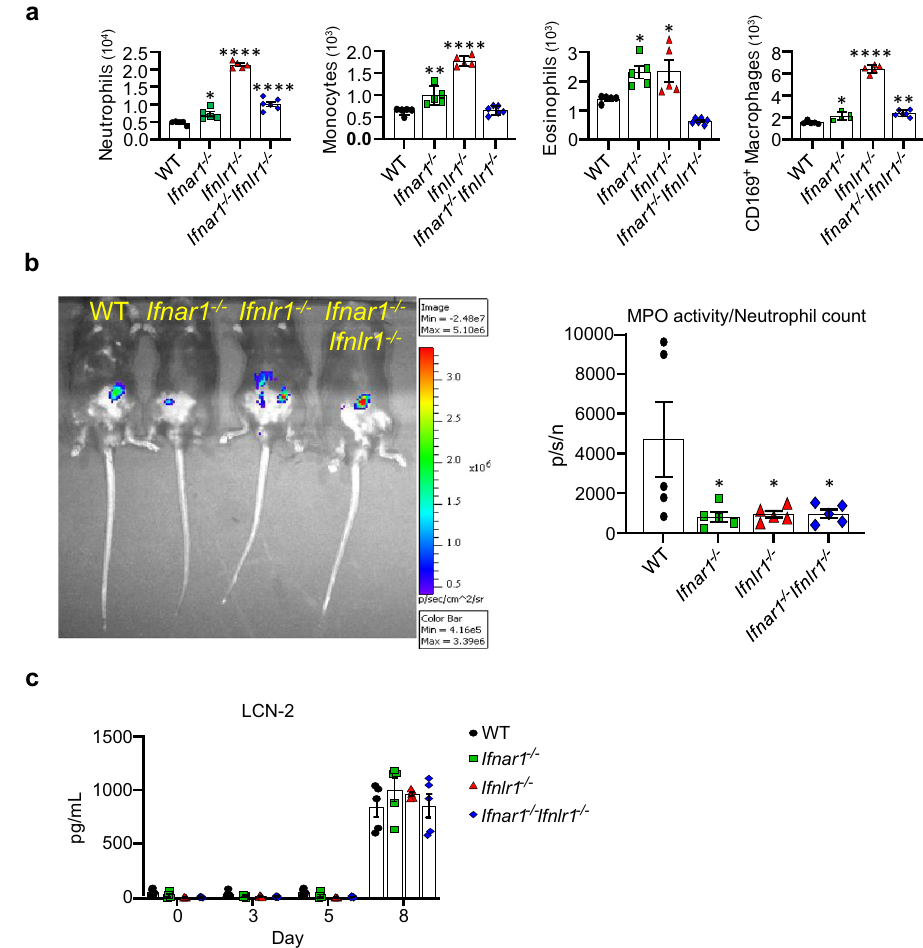
Fig. 3 Aberrant in fl ammatory response in the colon of IFNR-de fi cient mice following DSS treatment. a – c 6 – 8-week-old WT, single or double IFNR- de fi cient mice were exposed to 1.5% DSS in drinking water for 7 days, followed by regular drinking water for recovery. a Mice were euthanized on day 8 and immune cell in fi ltrates in the colon were enumerated by fl ow cytometry (WT, n = 5; Ifnar1 − / − , n = 5; Ifnlr1 − / − , n = 5; Ifnar1 − / − Ifnlr1 − / − , n = 6). b Neutrophil function was analyzed by evaluating myeloperoxidase (MPO) activity by measuring in vivo luminescence in mice injected with luminescent MPO substrate. Representative images display MPO activity (photon radiance (photons s − 1 cm − 2 steradian − 1 ; p/s/cm 2 /sr) presented as pseudo-color images ranging from red (most intense) to blue (least intense) superimposed over gray photographs. Relative MPO activity measured as photon fl ux (p/s) normalized to the number (p/s/n) of colon-in fi ltrating neutrophils (live, CD45 + CD11b + Ly6G + ) is shown ( n = 5). c Fecal lipocalin 2 (LCN-2) levels were measures by ELISA on selected days of experimental DSS-induced colitis ( n = 5). Data are representative of two independent experiments ( a , c ). Symbols represent values of individual mice ( a – c ). Quantitative data were analyzed using a , b one-way ANOVA or c two-way ANOVA followed by Bonferroni ’ s multiple comparisons test ( a – c ) and represent mean values with SEM. a * P = 0.0207 (neutrophils, Ifnar1 − / − ); ** P = 0.0016 (monocytes, Ifnar1 − / − ); * P = 0.0216 (eosinophils, Ifnar1 − / − ), * P = 0.0172 (eosinophils, Ifnlr1 − / − ); * P = 0.0296 (CD169 + macrophages, Ifnar1 − / − ), ** P = 0.0011 (CD169 + macrophages, Ifnar1 − / − Ifnlr1 − / − ). b * P = 0.0346 ( Ifnar1 − / − ), * P = 0.0417 ( Ifnlr1 − / − ), * P = 0.043 ( Ifnar1 − / − Ifnlr1 − / − ). **** P ≤ 0.0001. P values are for the indicated animal group compared with control group of WT mice ( a , b Ki-67 staining following the injury phase (day 8), when the histo- recruitment to the injured colon. However, the presence of an logical scores were similar between all mouse strains (Supplemen- aberrant in fl ammatory response in single IFNR-de fi cient mice tary Fig. 5b), and most of the crypts in the large intestine remained had no impact on survival, strongly suggesting that the enhanced intact. WT and Ifnlr1 − / − mice averaged 23 and 24 Ki-67 + cells per sensitivity to DSS exposure observed in Ifnar1 − / − Ifnlr1 − / − mice is not driven by an aberrant in fl ammatory response. crypt, respectively, while Ifnar1 − / − mice averaged only 15 Ki-67 + cells per crypt, and the mean in Ifnar1 − / − Ifnlr1 − / − mice was reduced to 8 cells per crypt (Fig. 4b). In addition, the crypts Colonic epithelium of Ifnar1 − / − Ifnlr1 − / − mice demonstrates appeared more elongated in WT and Ifnlr1 − / − mice then in Ifnar1 − / − or Ifnar1 − / − Ifnlr1 − / − mice, indicating faster cell proliferation decreased proliferation following DSS treatment . Since IECs are an integral part of the intestinal barrier 37 , we assessed whether the (Fig. 4b). This pattern of colonic Ki-67 staining correlates with failure of Ifnar1 − / − Ifnlr1 − / − mice to recover from DSS exposure weight loss (Fig. 1b) since both Ifnar1 − / − and Ifnar1 − / − Ifnlr1 − / − (Fig. 1a, b) could be due to a de fi ciency in mucosal regeneration. mice show signi fi cantly more weight loss following DSS exposure, Analysis of cell proliferation in the colon of IFNR-de fi cient mice at suggesting that Ifnar1 − / − mice also have increased sensitivity to steady state, as assessed by Ki-67 immunostaining, revealed no DSS exposure. Nevertheless, while Ifnar1 − / − mice have reduced signi fi cant difference from WT mice (Fig. 4a). We then evaluated